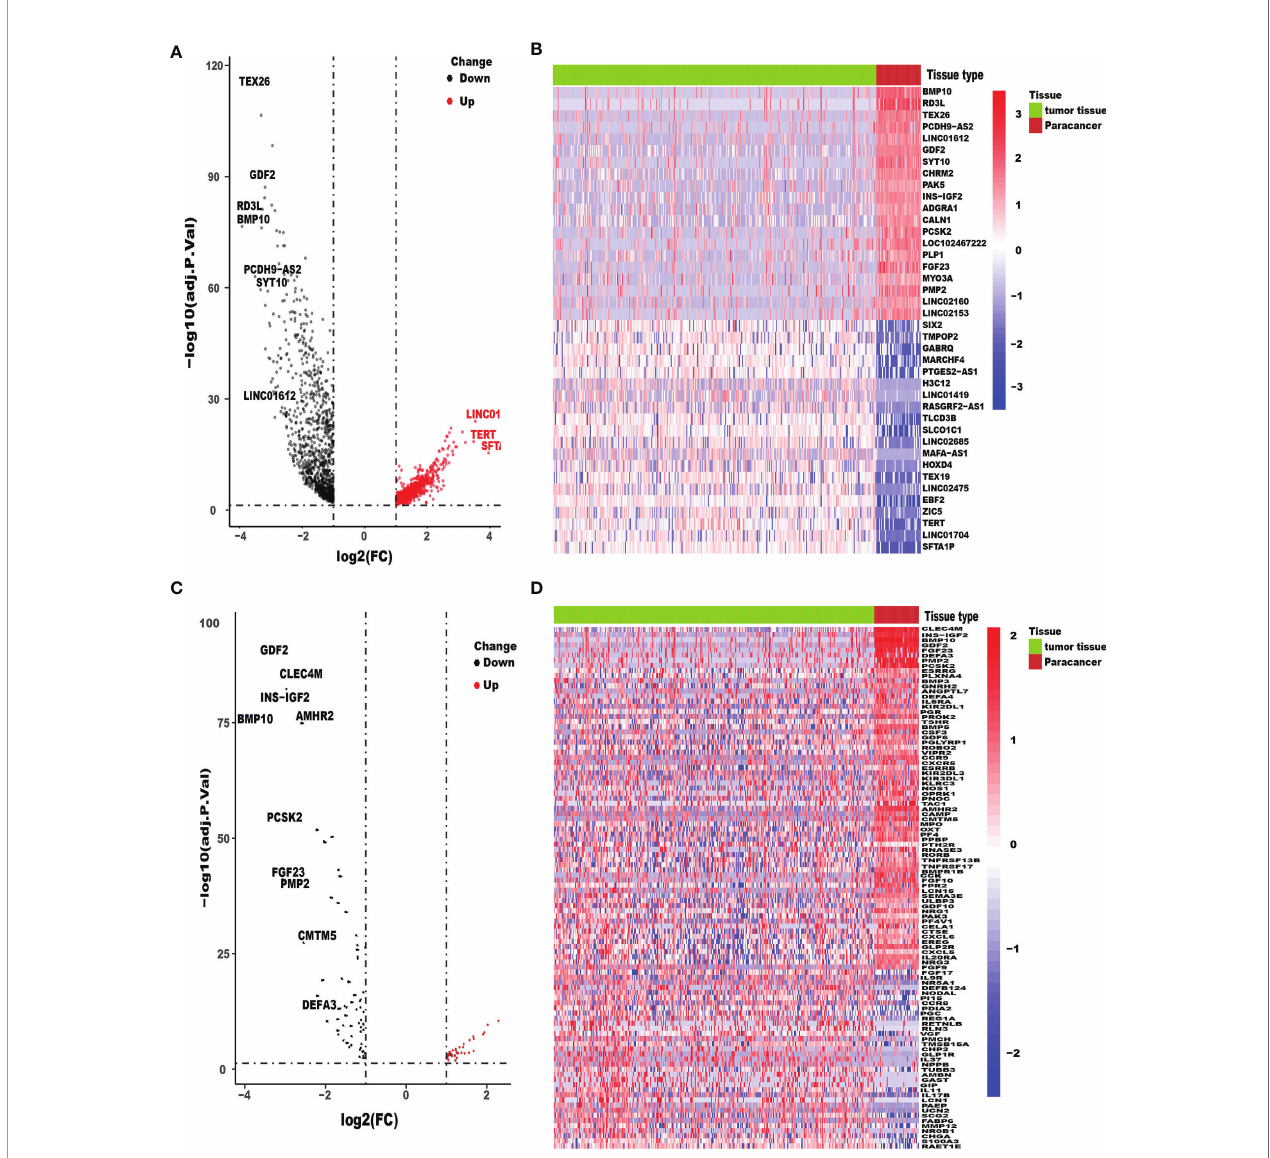
FIGURE 1 | Differentially expressed HCC genes and immune-related genes. Volcano plot (A) and heatmap (B) illustrated the differentially expressed genes between HCC tissues and para-carcinoma tissues. Immune-related genes (IRGs) with different expression levels were showed in the volcano plot (C) and heatmap (D) . FDR<0.05 and log 2 FC